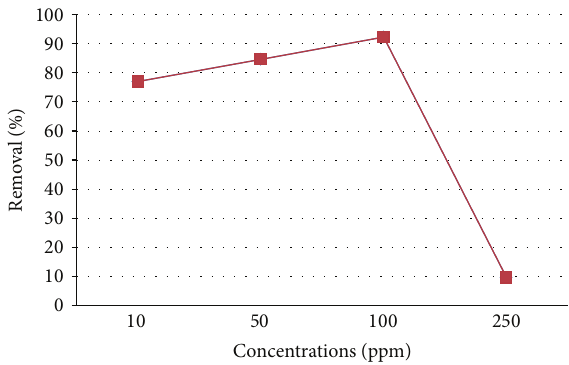
Figure 7: Effect of initial metal ion concentrations on metal ion removal using Schiff base.